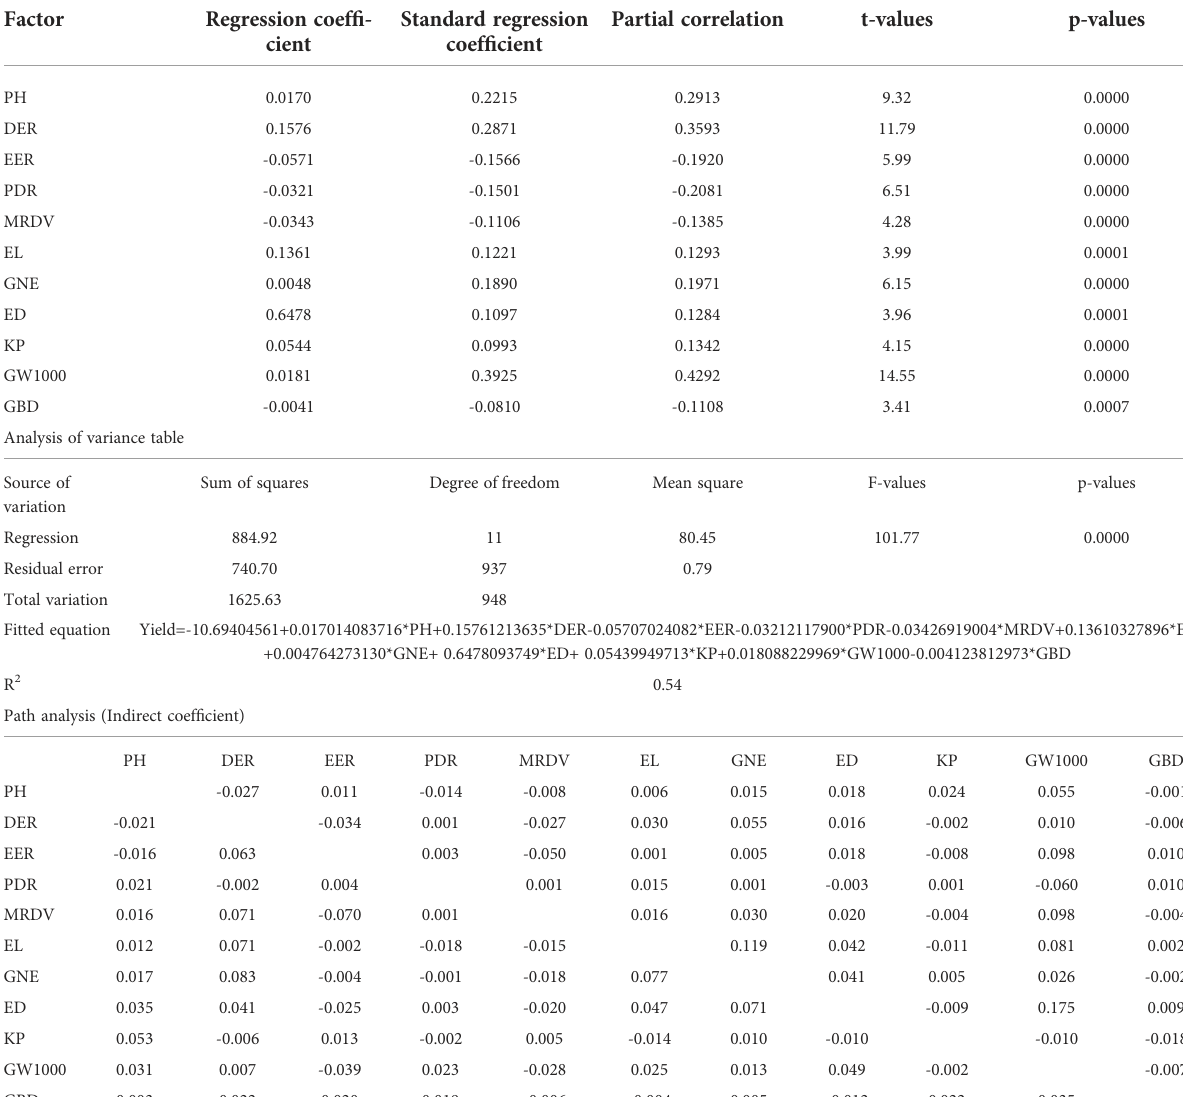
TABLE 5 Contribution rate of plant agronomic traits to yield (Path